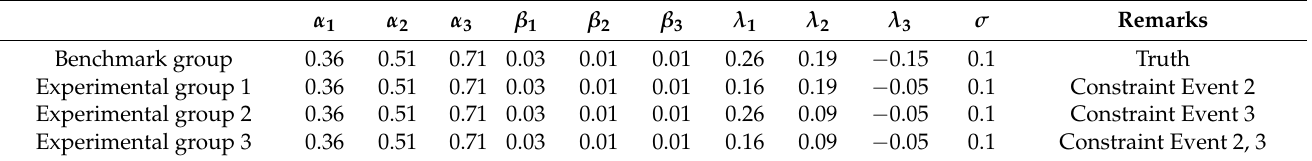
Table 7. Parameter settings considering effects of